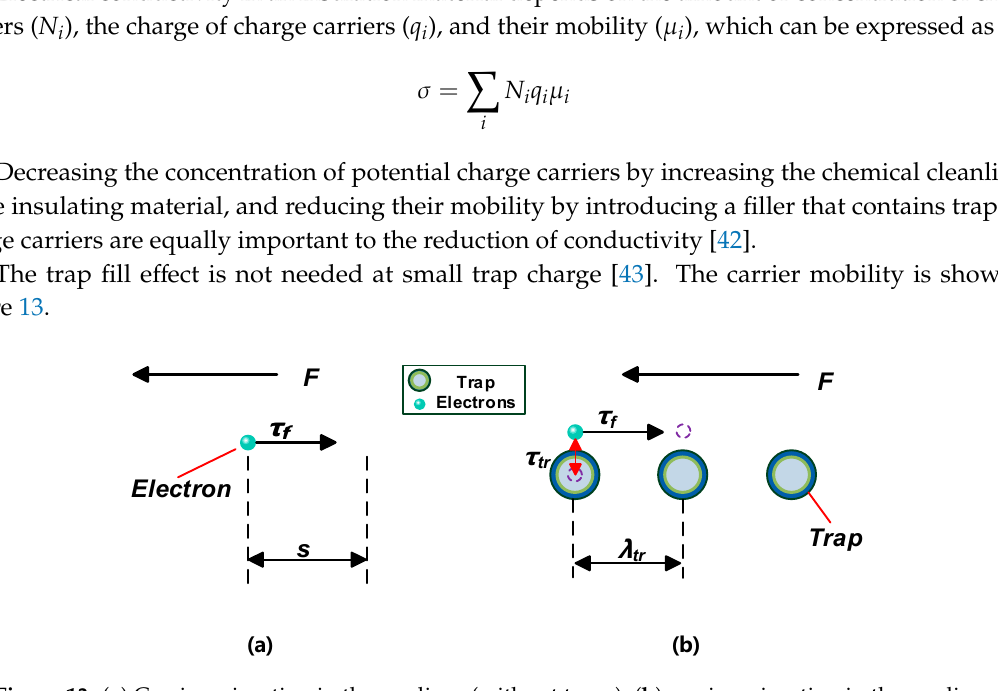
Figure 13. ( a ) Carrier migration in the medium (without traps), ( b ) carrier migration in the medium (with traps).